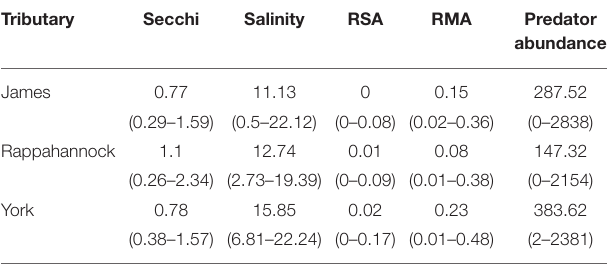
TABLE 3 | Mean (minimum–maximum) section-year values for Secchi disk depth, salinity, relative seagrass area (RSA), relative marsh area (RMA), and predator abundance for each tributary.